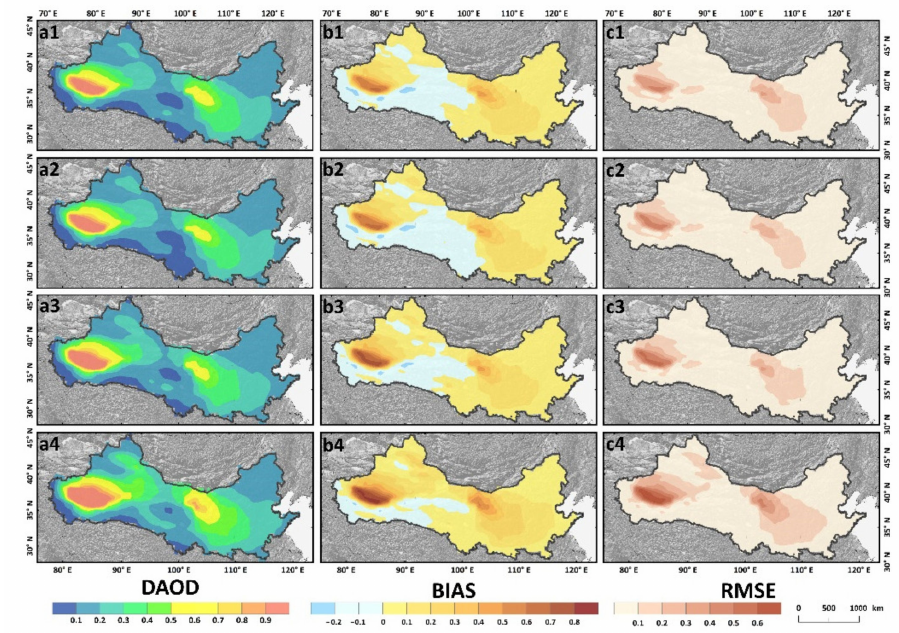
Figure A1. Spring DAOD, simulation bias, and RMSE in northern China from 2000–2015. ( a ) DAOD; ( b ) simulation bias; ( c ) simulation RMSE; 1. Dust simulation input based on our decision tree classification results with VCF data products (vcf5kyrv001), in which the land surface model is BATS; 2. Dust simulation based on ESA CCI-LC data, in which the land surface model is BATS; 3. Dust simulation based on GLCC data, in which the land surface model is BATS; 4. Dust simulation based on PTFs data, in which the land surface model is